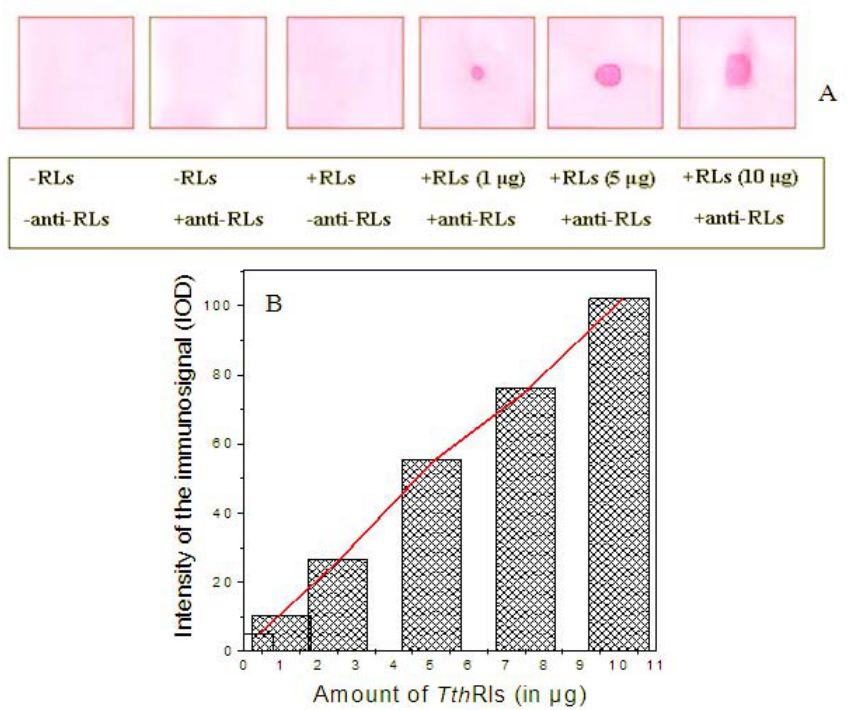
Figure 4. Detection limits of the anti- Tth RLs antibodies. ( A ) Immuno-dot blot assay performed by spotting various amounts of Tth RLs (1, 5 and 10 μ g), purified as described in Figure 3, and as it was determined by the colorimetric orcinol method using a standard curve of rhamnose. Then the membranes were probed with 1/500 dilution of rabbit polyclonal antiserum against Tth RLs. ( B ) Quantification of the intensity of immune- staining by the Gelpro Analyzer V.3 computer program (Histograms). Plot of the correlation between the immune-blot quantified by image analysis and the orcinol colorimetric method (in red